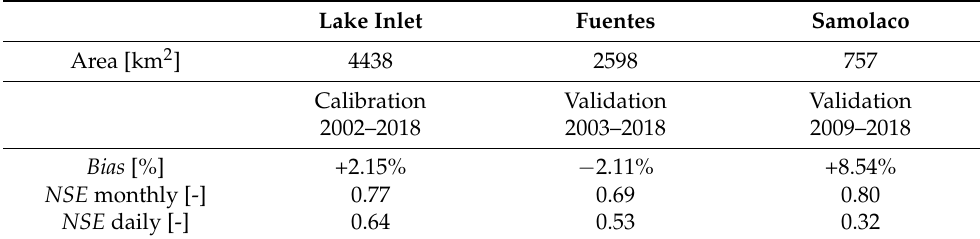
Table 2. Goodness of fit of modelled